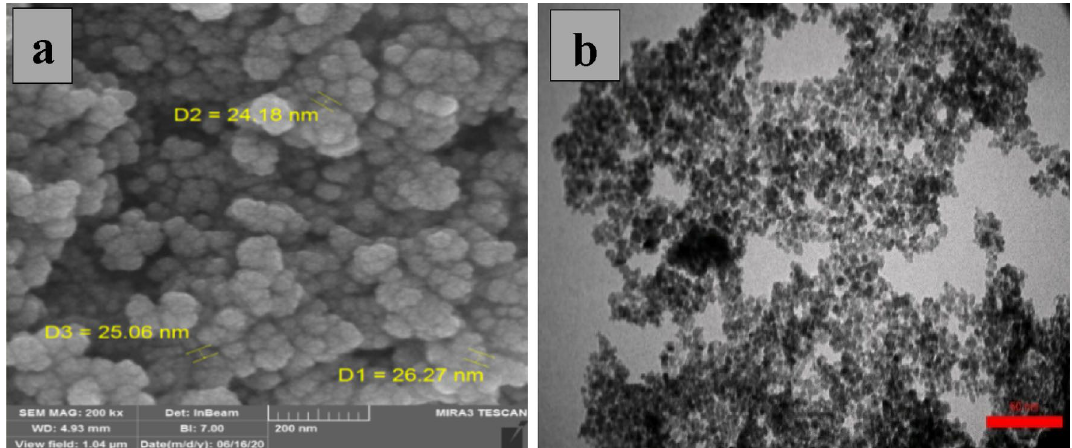
Figure 5. ( a ) FESEM and ( b ) TEM image of FNAOSiPAMP/Cu II .